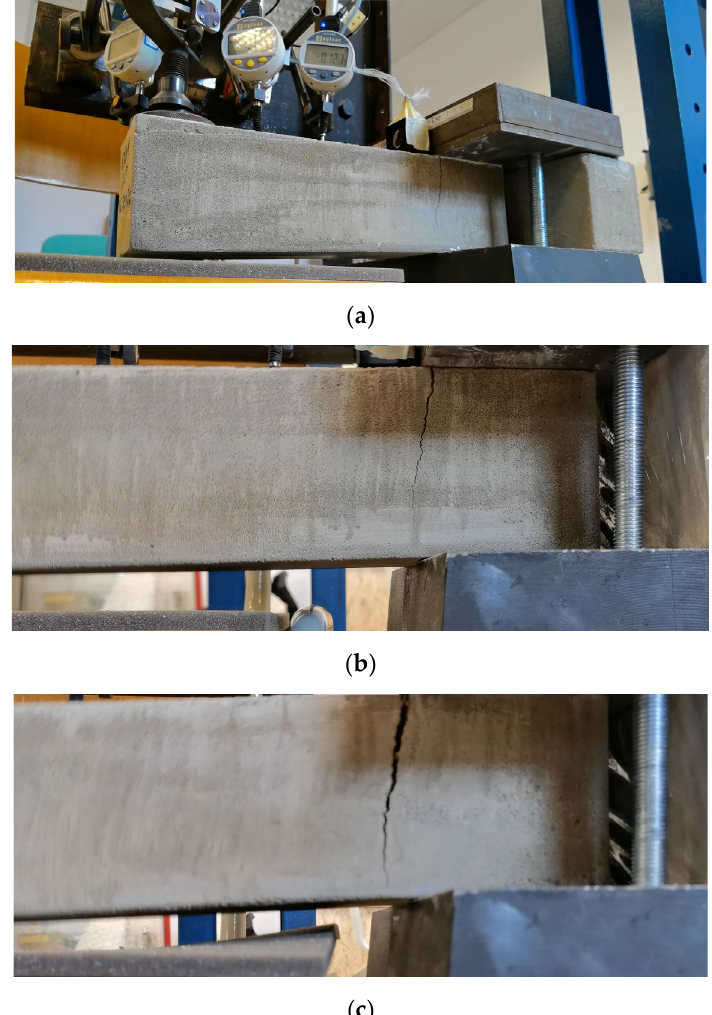
Figure 13. Crack development FC specimen 35030420: ( a ) collapse—first stage, creation of the crack; ( b ) second stage—crack propagation over specimen cross-section; ( c ) third stage—total collapse, crack over full cross -section.